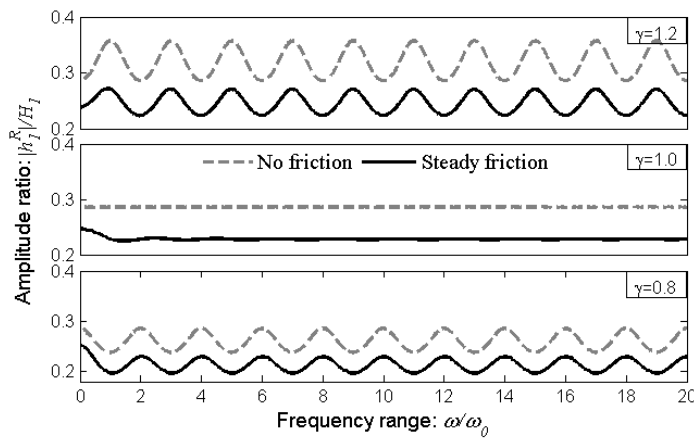
κ= ) on the frequency response